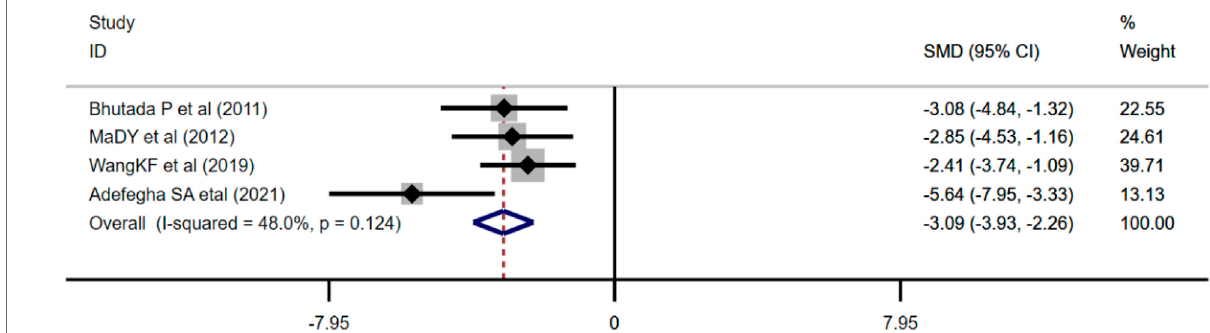
FIGURE 9 | Forest plot: effect of berberine on AChE.